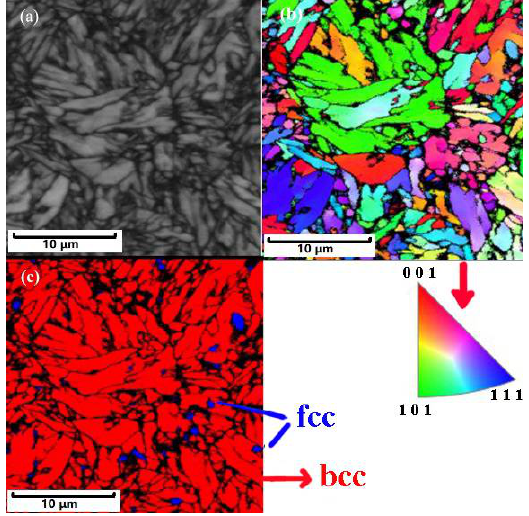
Figure 5. The electron backscattering diffraction analysis ( a ) overall image quality (IQ) map, ( b ) bcc phase inverse pole figure (IPF) map, and ( c ) phase map of sample quenched to 220 °C and partitioned-tempered at 400 °C for 60 s.